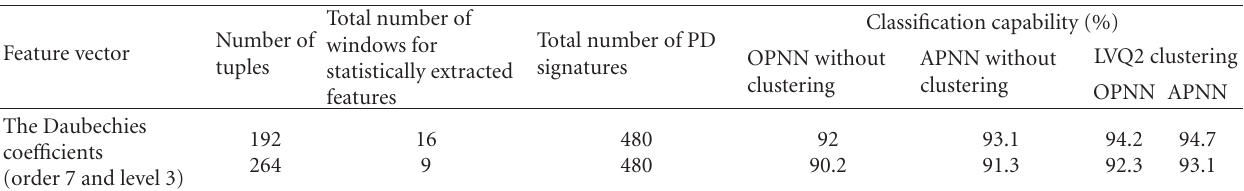
Table 10: Capability of wavelet transform-PNN in classifying multiple source PD